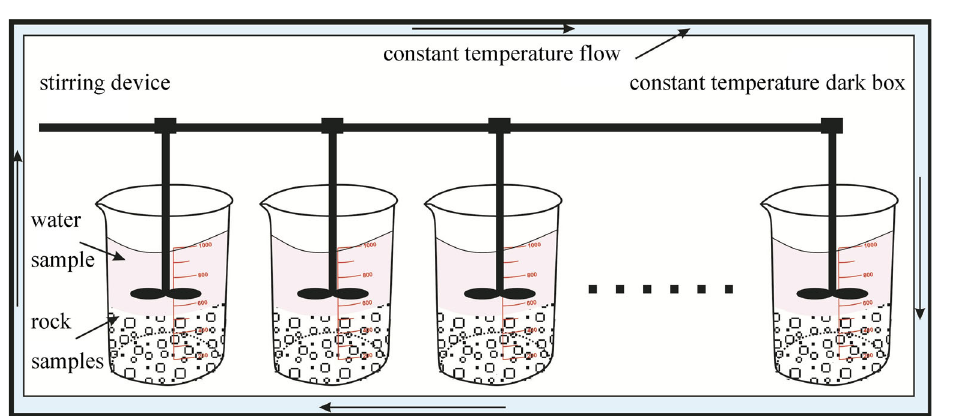
Fig. 2 Simulation experiment setup for water–rock interaction in groundwater